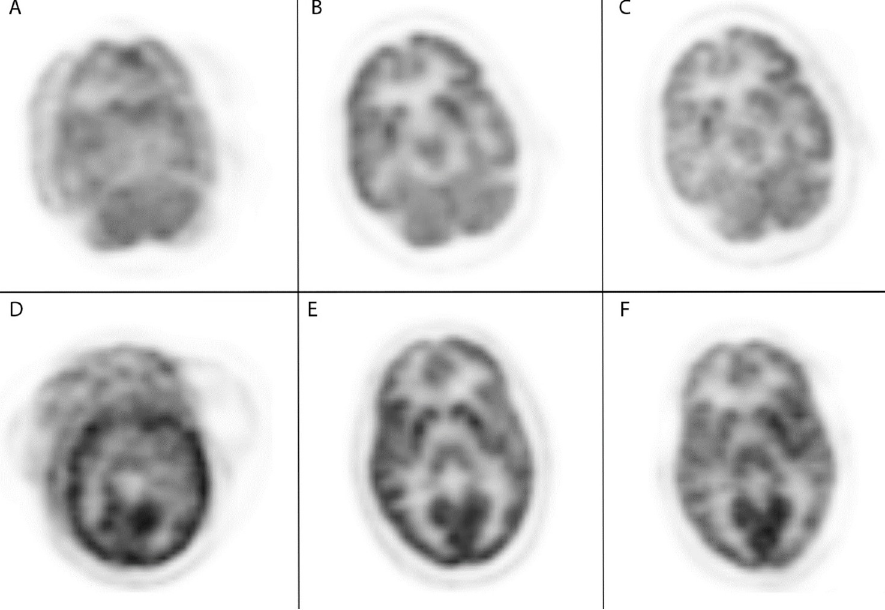
Fig 5. Reconstructed axial comparisons of uncorrected data, frame-based corrected data, and event-based corrected data. Reconstruction example for Patient Study 3 (Top row) and Patient Study 5 (Bottom row) in the axial plane: (A, D) original motion impacted data; (B, E) frame-based correction; (C, F) event-based correction. Both datasets were set to a window of 4% of the maximum value.